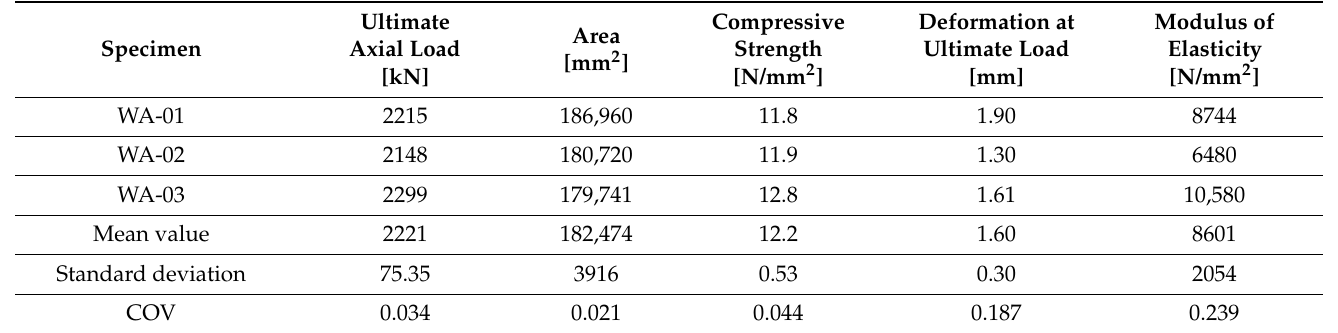
Table 8. Maximum force, maximum stress, and modulus of elasticity of unreinforced wallettes under axial compression test.